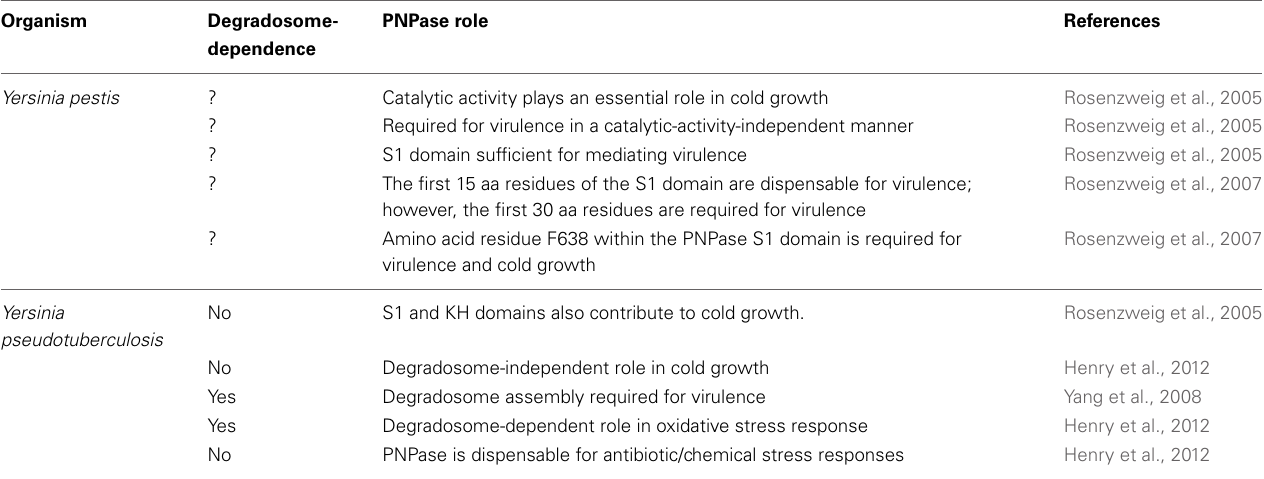
Table 2 | List of PNPase determinants in yersiniae stress responses.